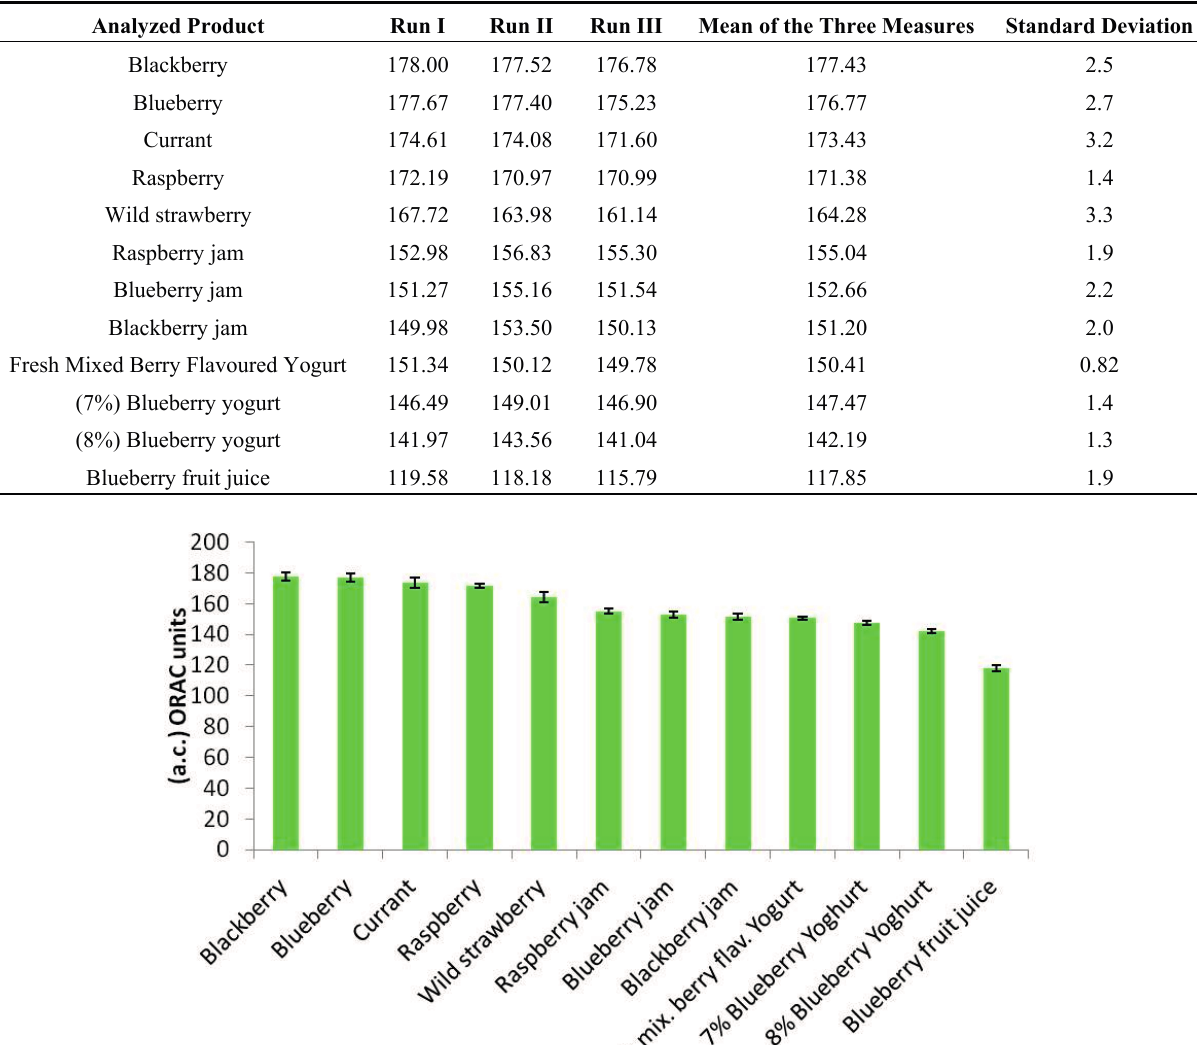
Table 3. Repeated test results using the ORAC spectrofluorimetric method,values expressed in ORAC units.